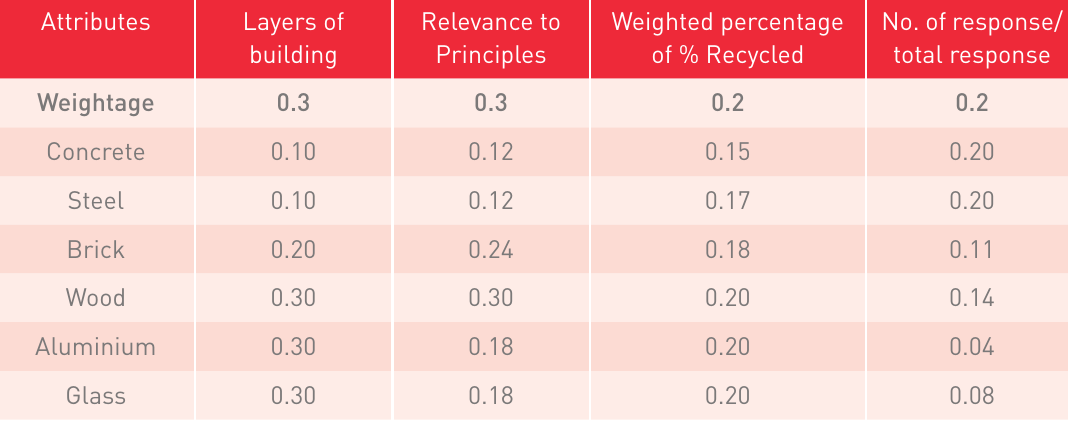
Table 9. Weighted Normalised matrix Attributes Layers of